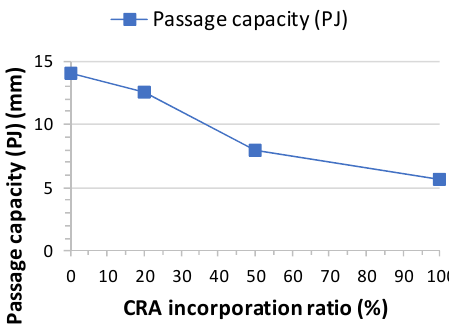
Figure 8. Slump flow test results.